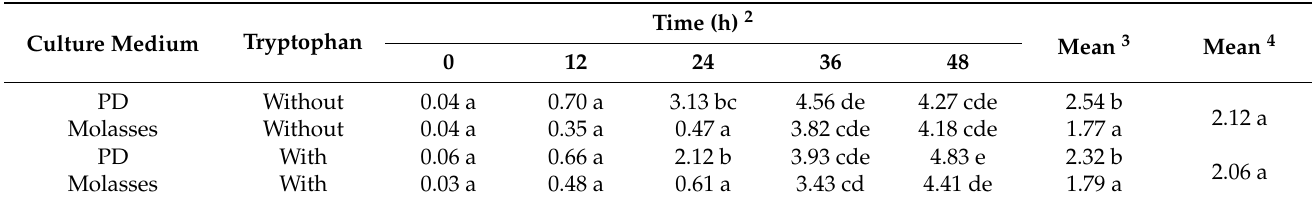
Table 2. Statistical results of growth (optical density) of C. vulgaris in potato dextrose broth (PD) and molasses, with or without tryptophan, by Tukey’s test ( p < 0.05) 1 .